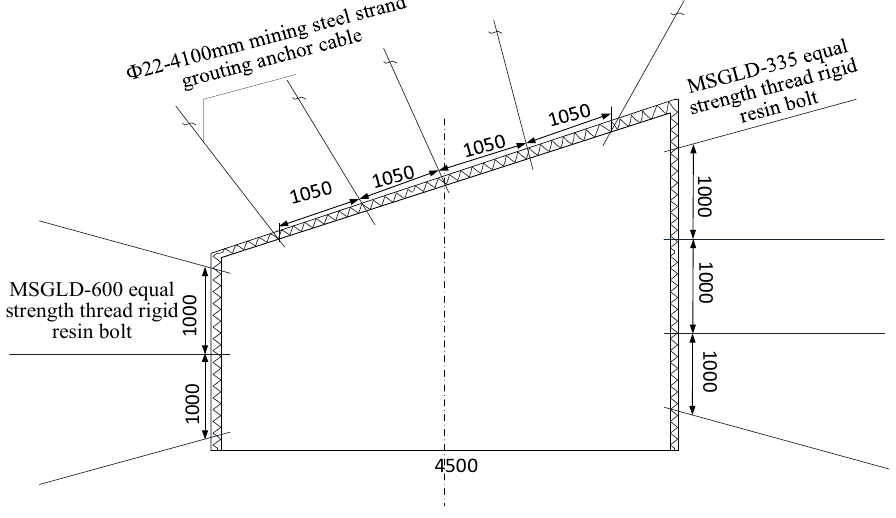
Figure 2. Roadway once support section diagram.